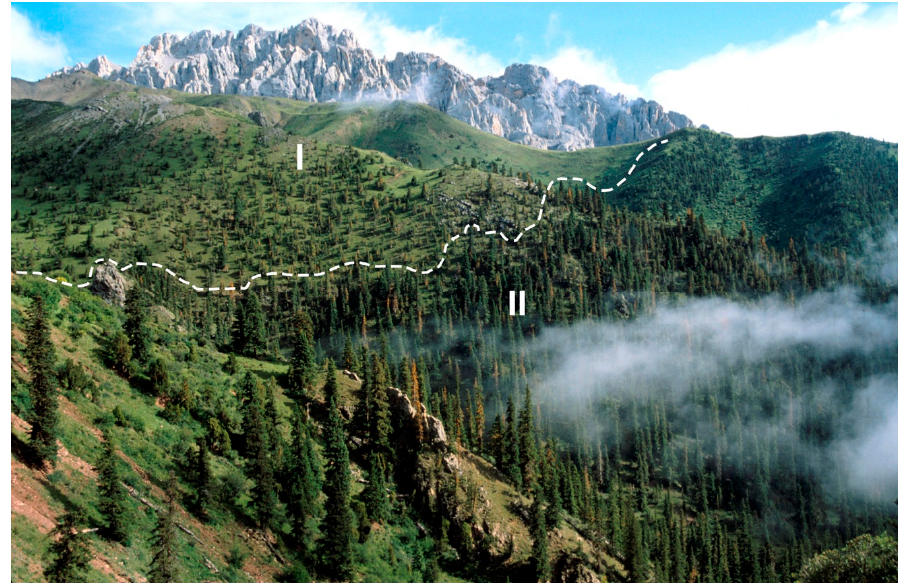
Figure 2 . Overview on the sampling site near Qamdo: (I) area of predominant Juniperus tibetica tree-stands on southerly expositions at 4400–4600 m asl.; and (II) vegetation belt with the Picea balfouriana forest on southeasterly expositions.